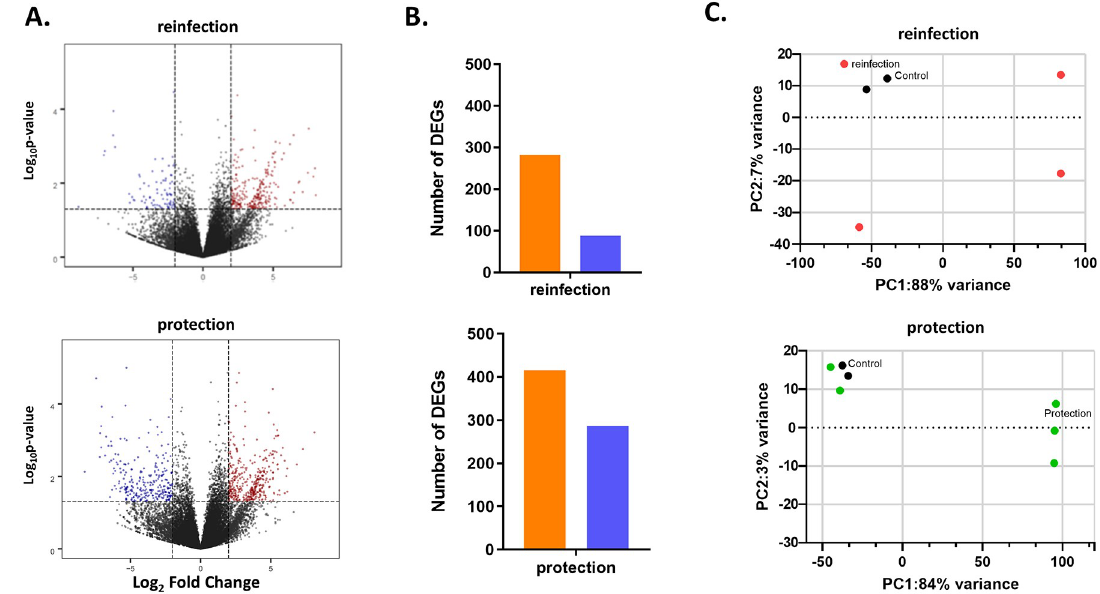
Fig 6. Identification of differentially expressed genes (DEGs) in the liver tissues of seroconverted rhesus macaques with homologous HEV gt1 reinoculation. (A), Volcano plot showing DEGs in reinfected and protected animals after HEV gt1 reinoculation compared to two na ï ve control animals. Red-dot, upregulated genes; blue-dot, downregulated genes. (B), Bar chart of DEGs found to be upregulated or downregulated in reinfected and protected animals after HEV gt1 inoculation. (C), Principal component analysis (PCA) of each liver sample of reinfected and protected animals after HEV gt1 inoculation and controls on the basis of 33,372 unique